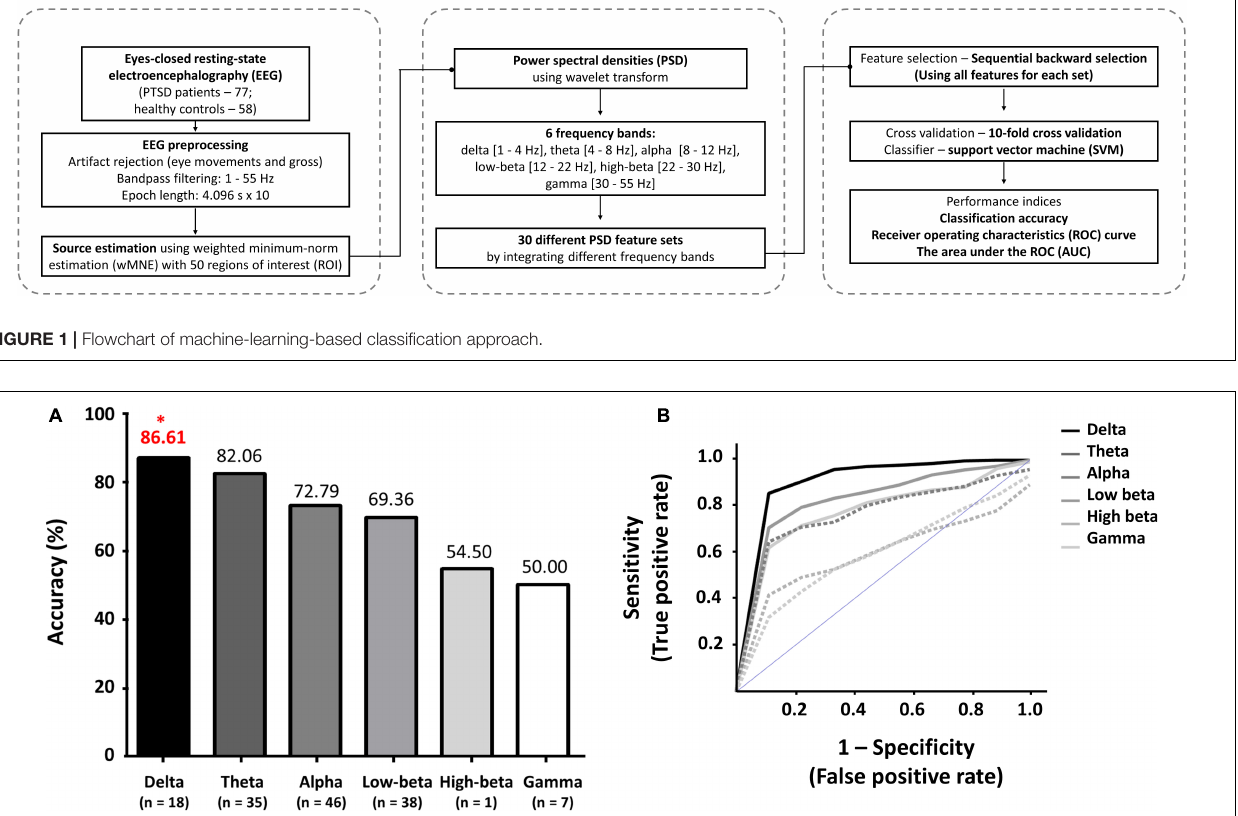
FIGURE 2 | (A) Maximum classification accuracies of each frequency band, and (B) Receiver operating characteristic (ROC) curves with corresponding areas under the curves (AUC) for each frequency band. *indicates a maximum classification